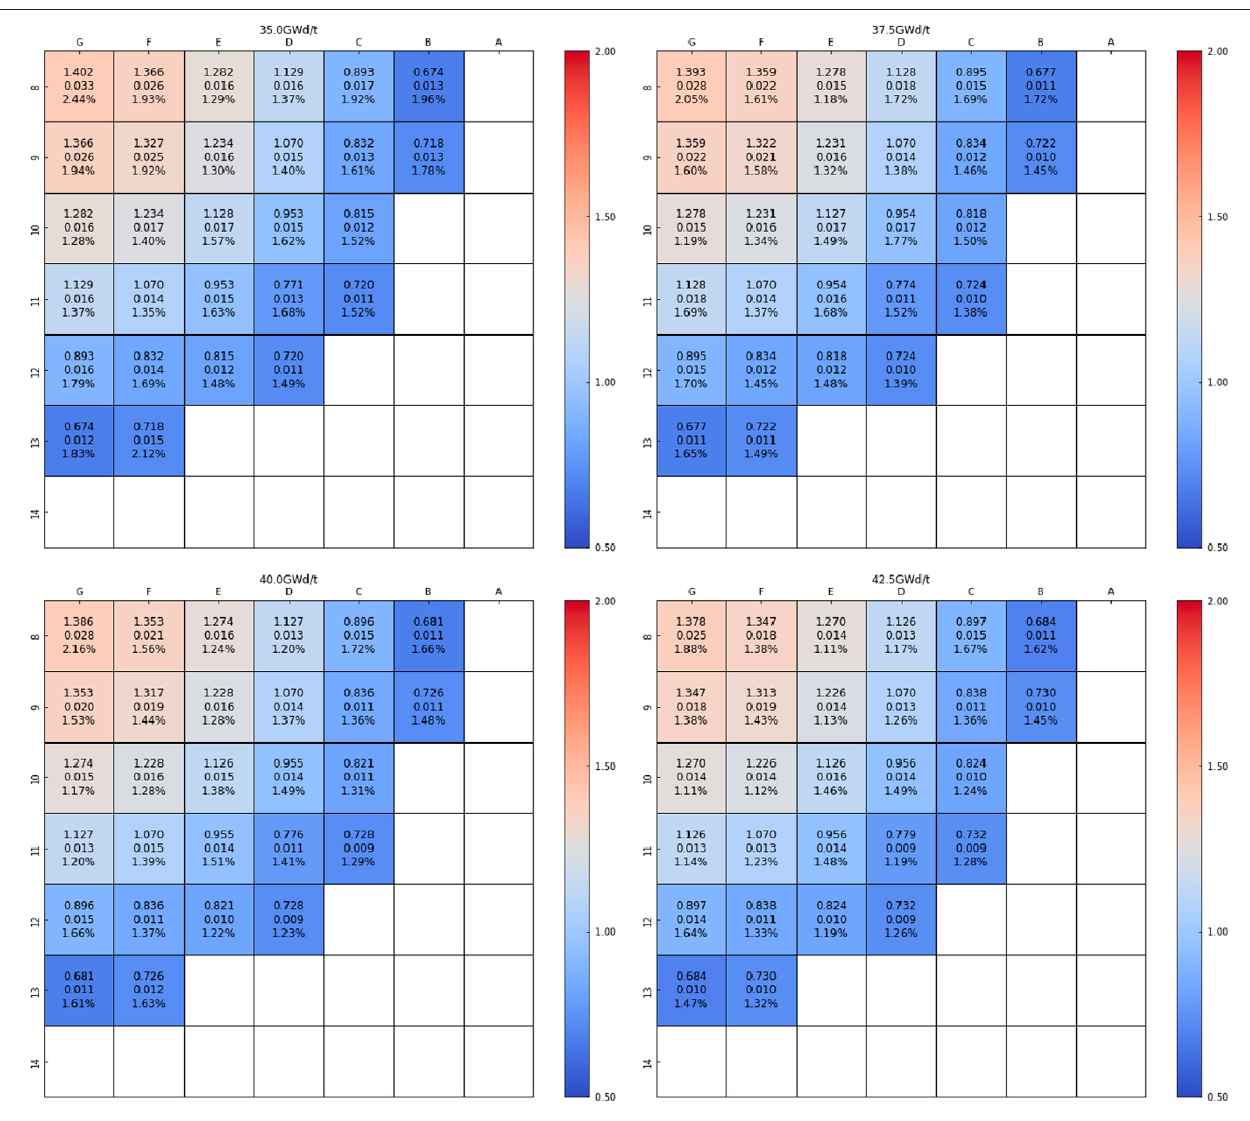
Frontiers in Energy Research |